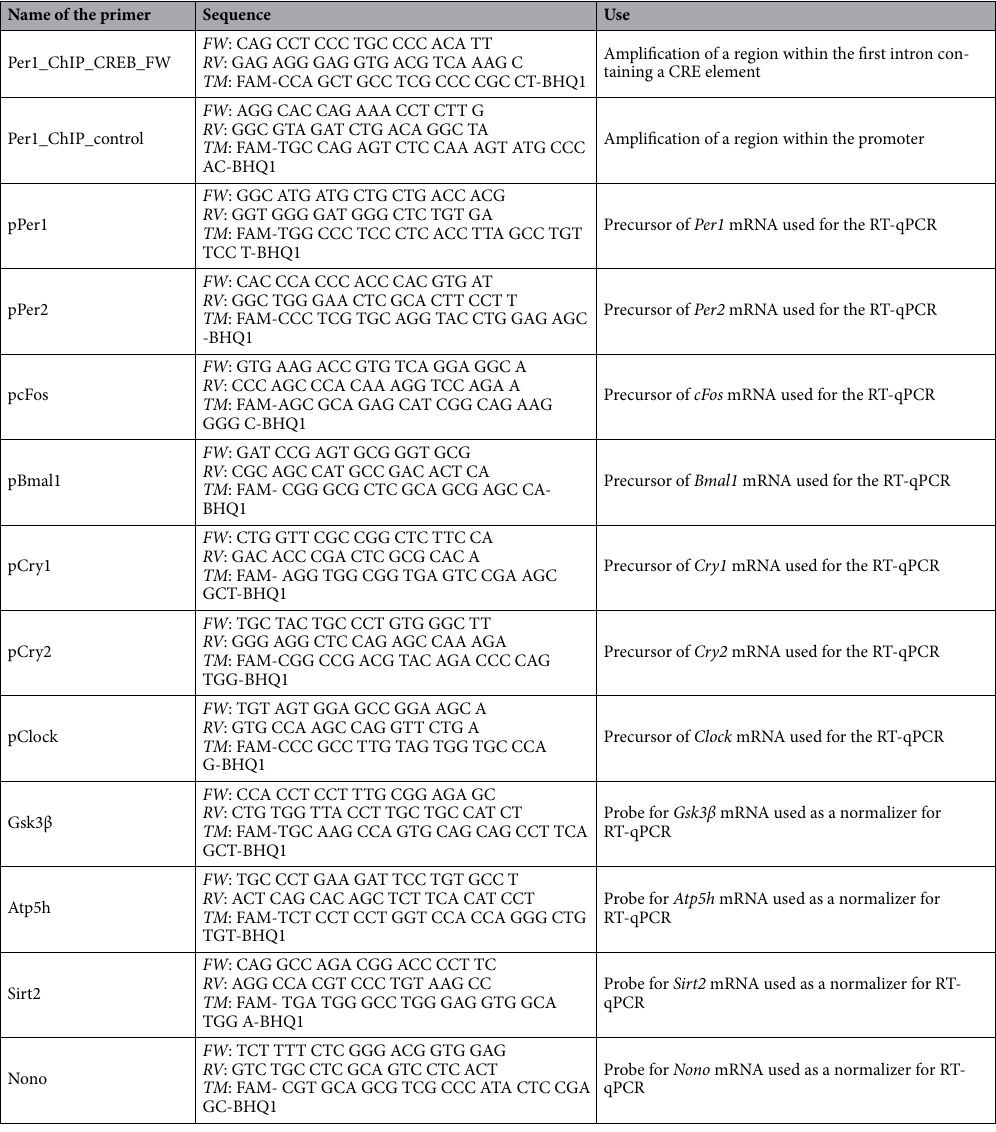
Table 1. List of primers used in the paper (5 ′ –3 ′ ; FAM: 6-fluorescin, BHQ1: black hole quencher